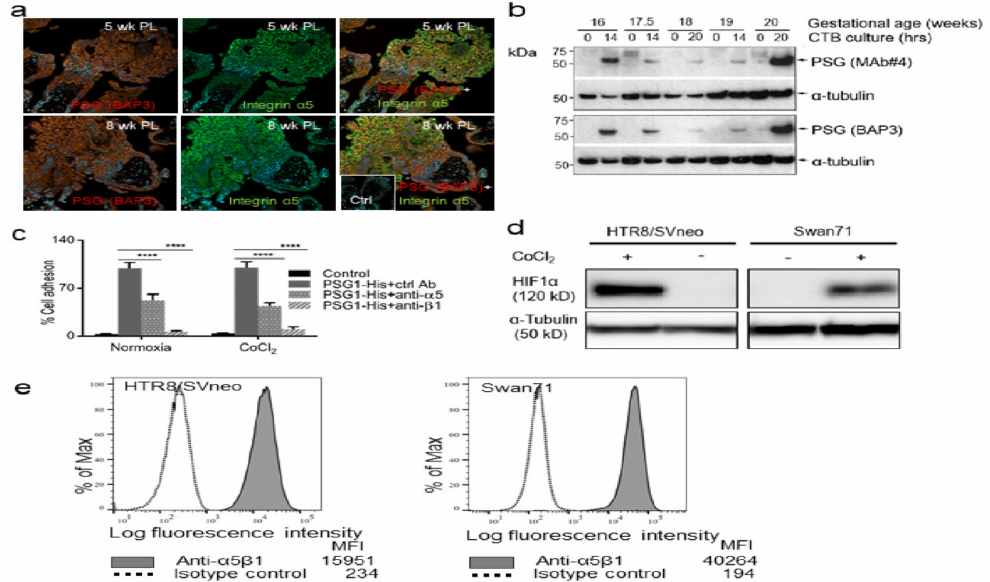
Figure A1. Co-localization of PSGs with integrin α 5, PSG1 expression in EVTs di ff erentiated in vitro, PSG1-mediated adhesion of HTR8 / SVneo cells, HIF1 α stabilization by CoCl 2 and integrin α 5 β 1 expression in EVT-like cell lines. ( a ) Representative photographs of dual fluorescent immunohistochemistry localizing PSGs (red) and integrin α 5 (green) are shown in both individual and dual channels in sections of first-trimester placenta. Scale bars = 45 µ m. ctrl = control Ab. ( b ) Immunoblot of cytotrophoblast (CTB) lysates with two di ff erent anti-PSG mAbs shows no PSG expression in undi ff erentiated (0 h) second-trimester CTBs but high expression in the EVTs that were di ff erentiated in vitro (14 h and 20 h) from second-trimester CTBs. ( c ) HTR8 / SVneo cells that were pre-incubated with the indicated Abs were seeded on wells coated with 30 µ g / mL PSG1-His or control protein. When indicated, cells were pre-treated 4 h with 100 µ M CoCl 2 and the treatment was maintained during the experiment. Cell adhesion experiments were carried out as described in Figure 2. ( d ) Representative image of Western blot showing HIF1 α stabilization in HTR8 / SVneo and Swan71 cells treated with 100 µ M CoCl 2 for 4 h. ( e ) HTR8 / SVneo and Swan71 were incubated with anti-integrin α 5 β 1 or isotype control mAb followed by APC-conjugated anti-mouse Ig. MFI = mean fluorescence